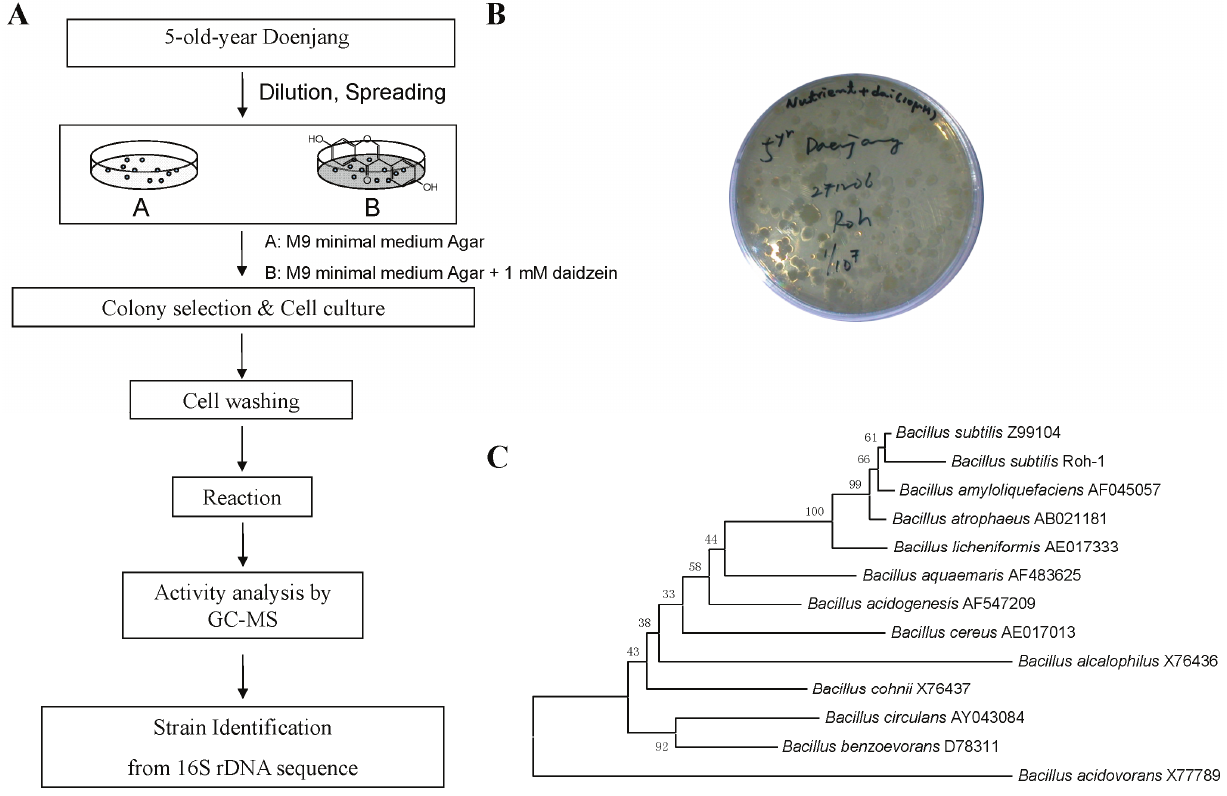
Figure 3. Microorganism screened from soybean Doenjang. ( A ) Strategy of strain screening from Doenjang; ( B ) Strain Roh-1 screened; ( C ) Phylogenetic tree based on 16S rRNA gene sequences showing the relationships between strain Roh-1 and other type strains. Bar, 0.01 means substitutions per nucleotide